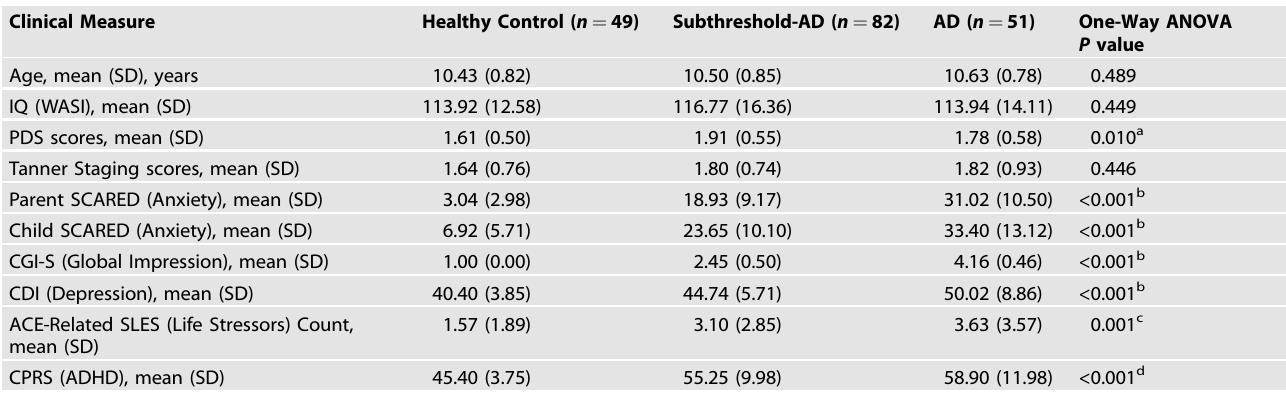
Table 2. Sample characteristics by cohort at study